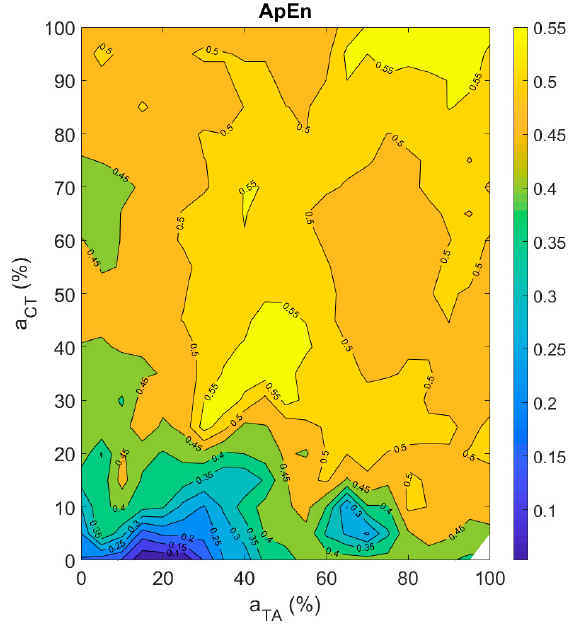
Figure 9. Muscle activation plot with approximate entropy as the contour feature.